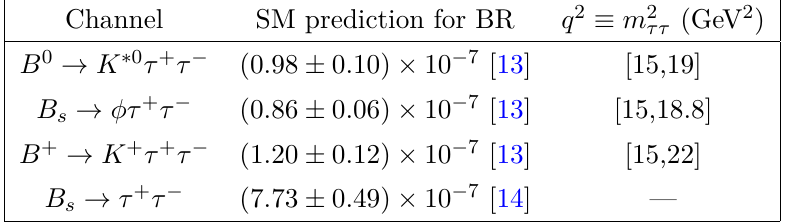
Table 3 . Four b → sτ + τ − benchmark channels. The B -meson decay widths are calculated in a phase space selected by q 2 , where the impacts of the ψ (2 S ) resonance ( m their measurements are